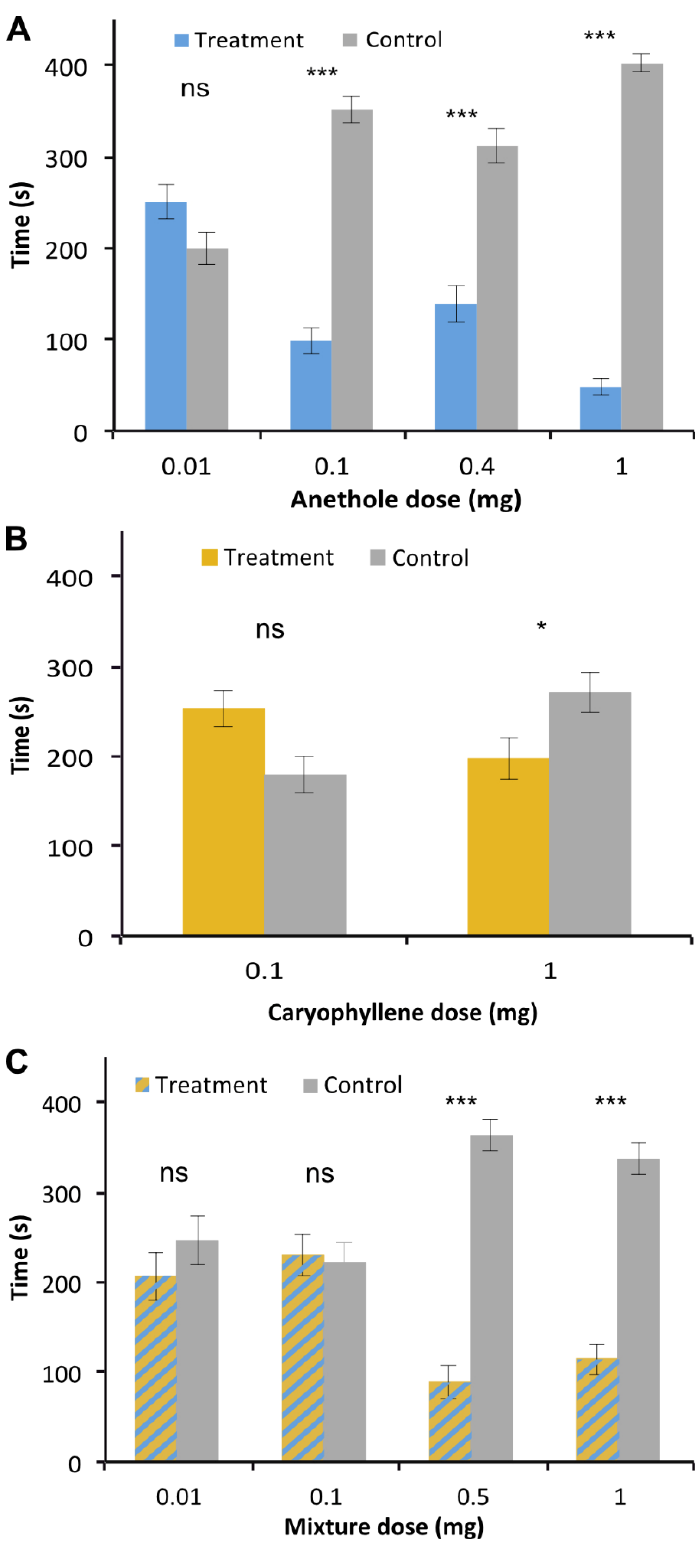
Figure 2. Behavioral effects of major individual compounds of the V. globosa essential oil and their mixture. ( A ) Responses to anethole. ( B ) Responses to caryophyllene. ( C ) Responses to the mixture of anethole and caryophyllene. n = 28–31; ns, not significant, * 0.05 > p > 0.01, *** p ≤ 0.001. 2.4. Inhibition of Behavioral Aggregation Pheromone Attractiveness by V. globosa Essential Oil Five beetles in a stimulation tube were highly attractive to individual T. confusum , confirming earlier results [9] (Figure 3, p < 0.0001). When combining this attractive stim-